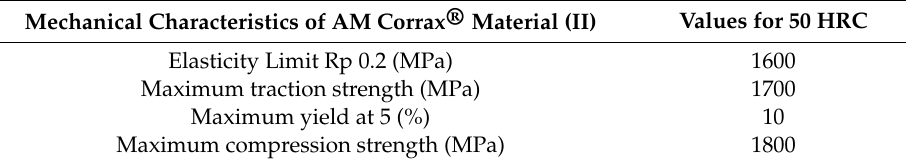
Table 2. Mechanical characteristics of AM Corrax ® material (and II).